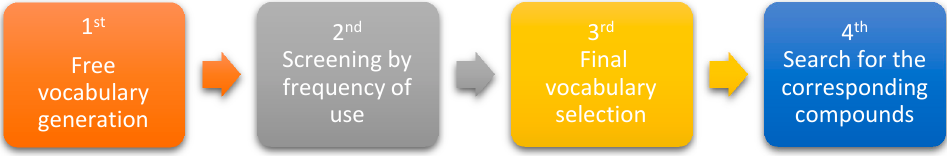
Figure 2. Schematic representation of the methodology used in the identification and selection of aromatic descriptors of tawny port wine.